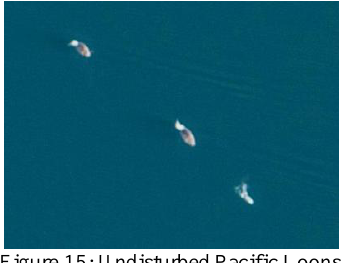
Figure 15: Undisturbed Pacific Loons